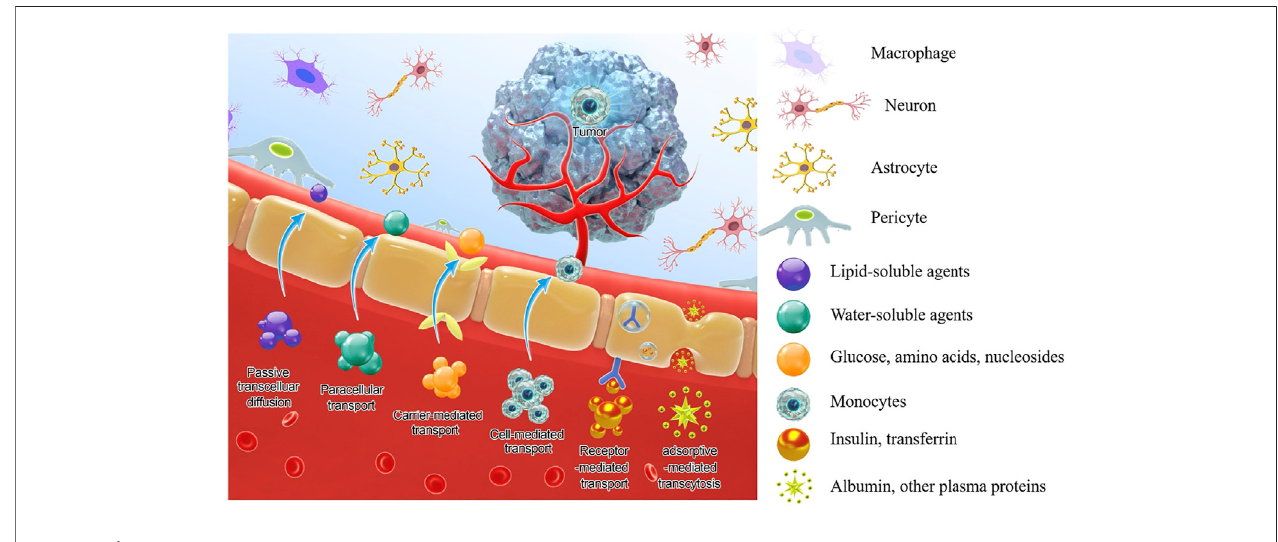
FIGURE 1 | Structure of the BBB and pathways to cross the BBB.